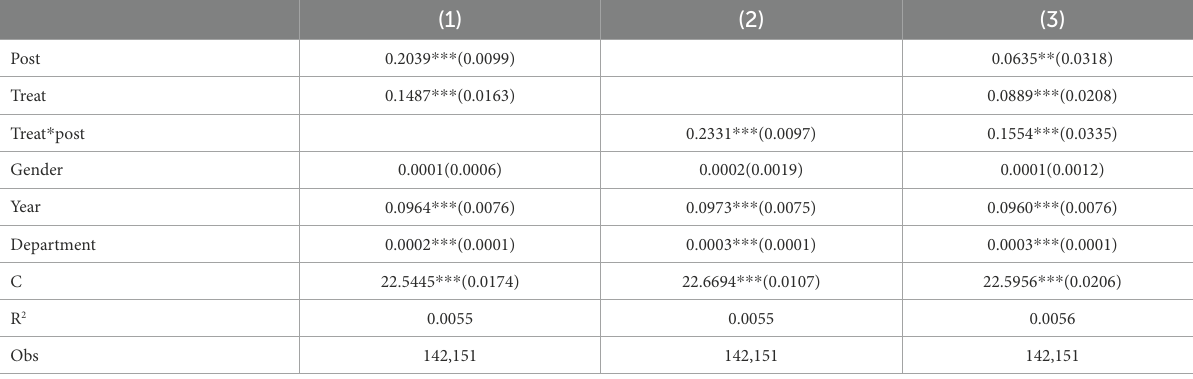
TABLE 6 Robustness test of substitution